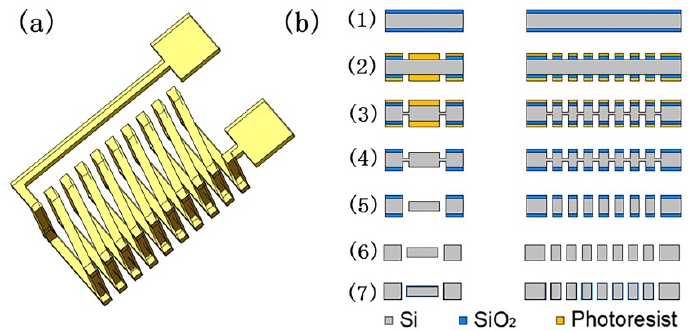
Figure 1. ( a ) 3D schematic of an in-chip solenoid metal wiring and ( b ) fabrication procedures of the 3D in-chip solenoid cavities.